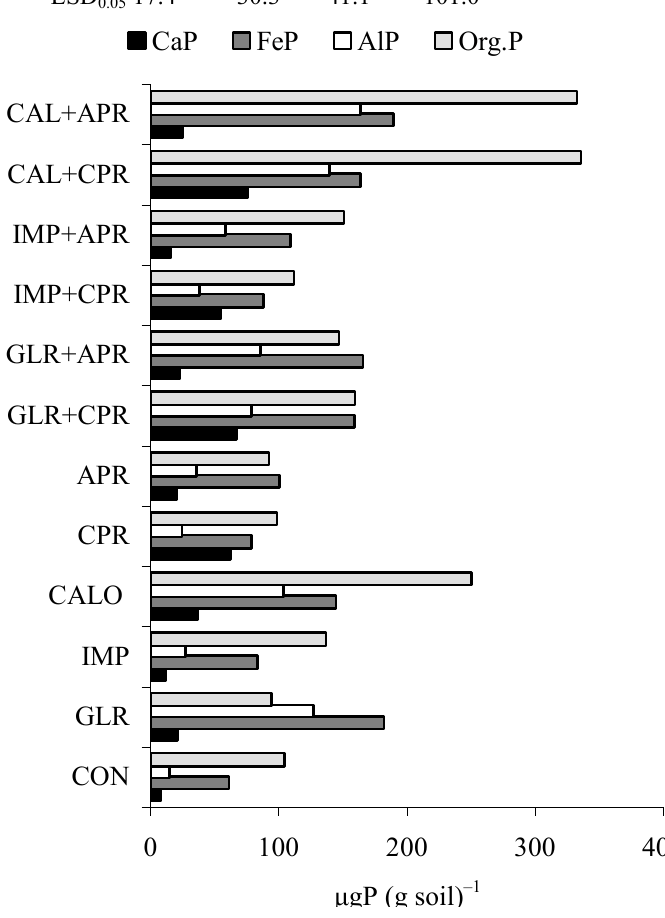
FIGURE 7. Fractions of P in a tropical soil treated with GMs and PRs after 16 months of